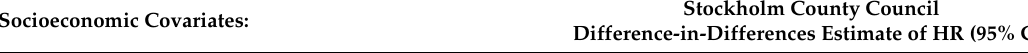
Table 3. Cox regression of the socioeconomic covariates related to paediatric inpatient and outpatient care of viral gastroenteritis in Stockholm County